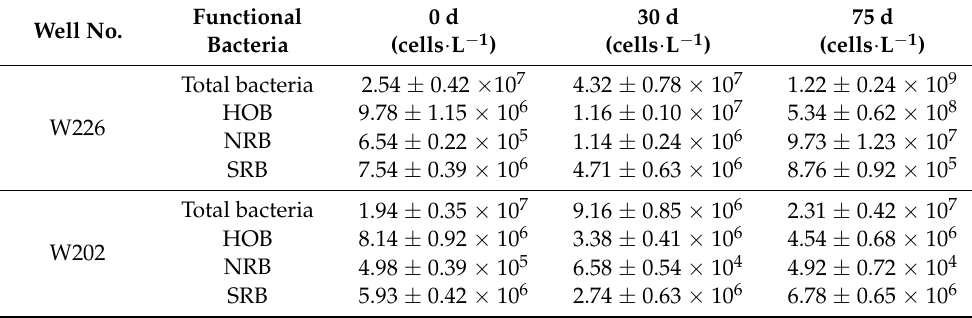
Table 4. Enumeration of functional microorganisms in oil reservoirs.